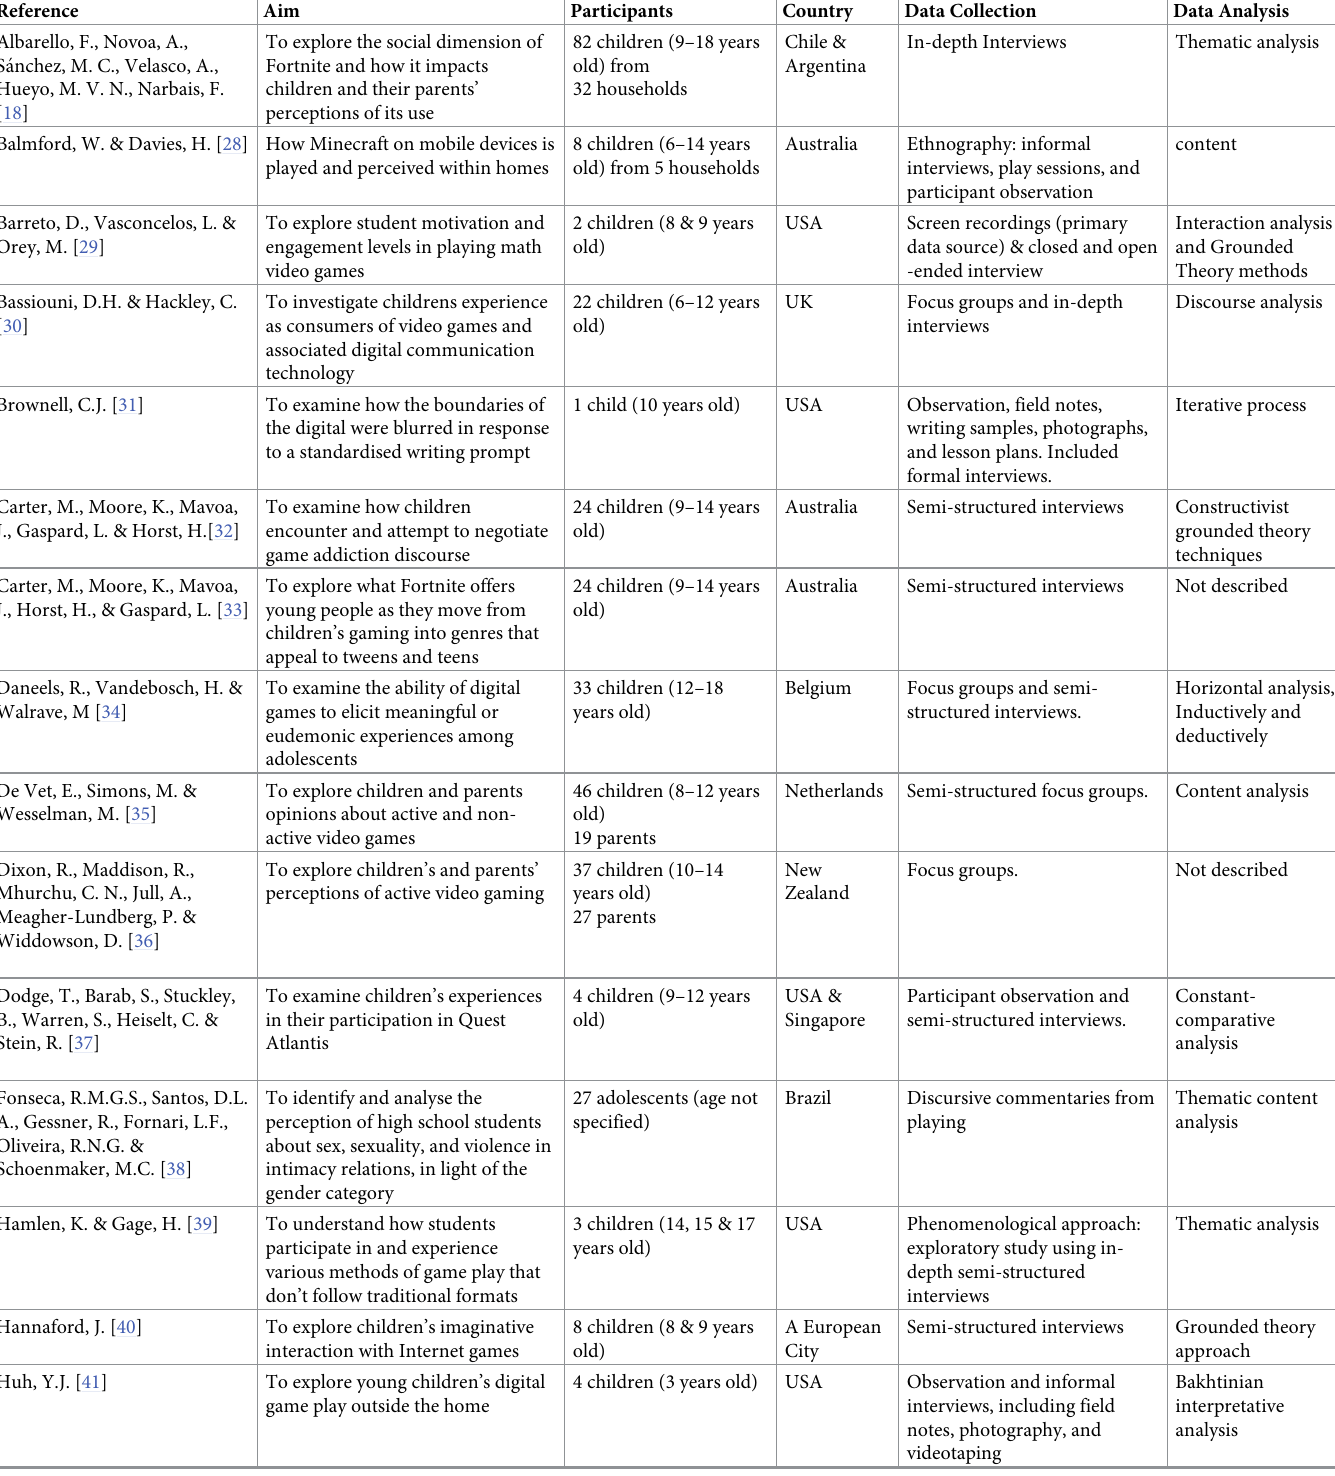
Table 2. Characteristics of included